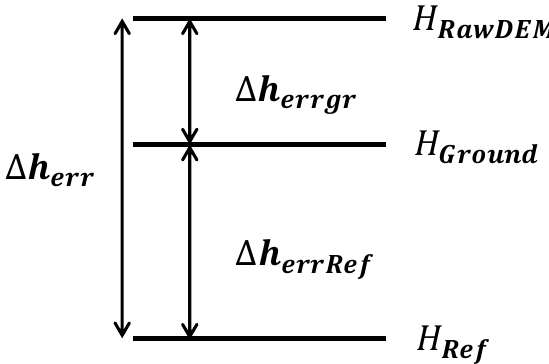
Figure 1. Composition of a height error [15].